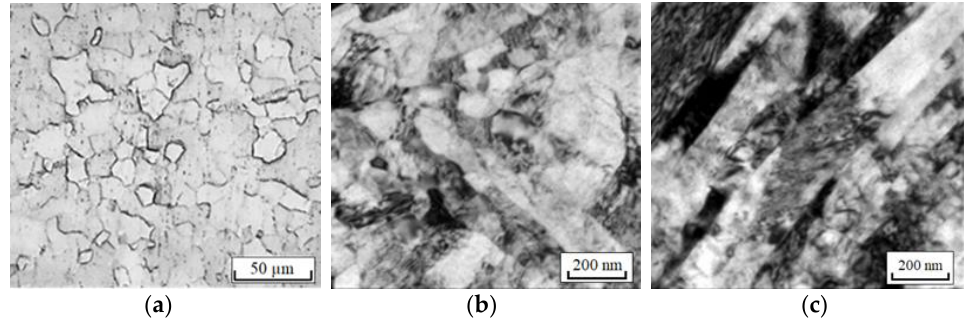
Figure 1. Microstructure of titanium in CG ( a ) and UFG ( b , c ) states: ( a ) — along; ( b ) — cross section; ( c ) — longitudinal section.